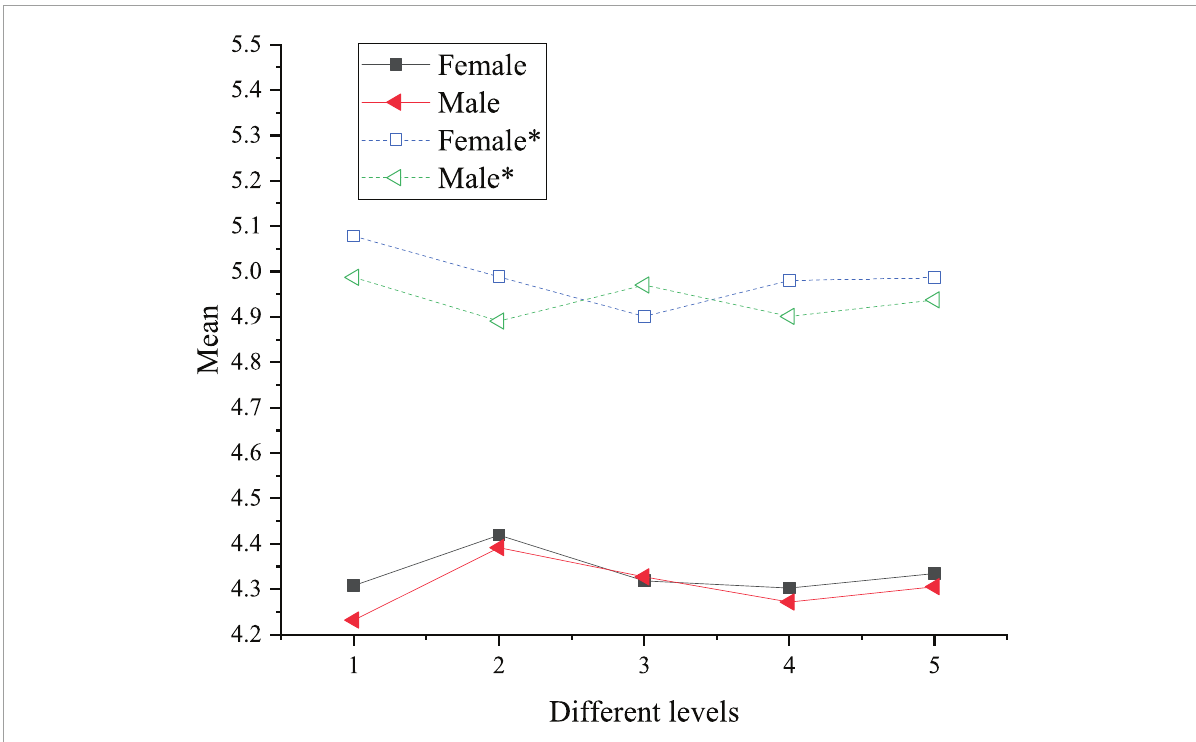
FIGURE2 Comparison of the national cognition and cultural acceptance of college students of different genders before and after reading art journals. * denotes post-test